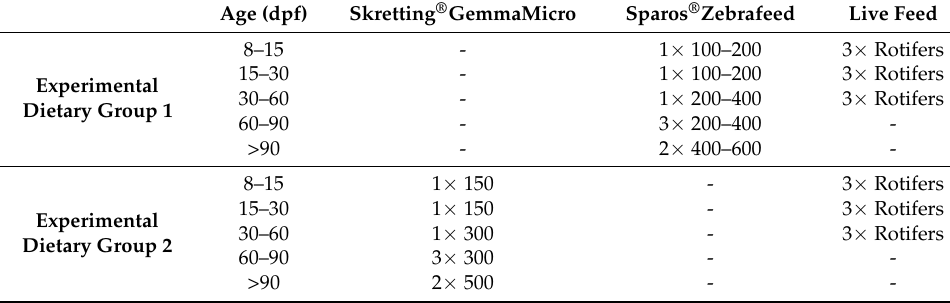
Table 1. Experimental dietary groups, starting at 8 days post-fertilization (dpf). The number of daily meals of each feed is listed as well as the size of the grains of processed